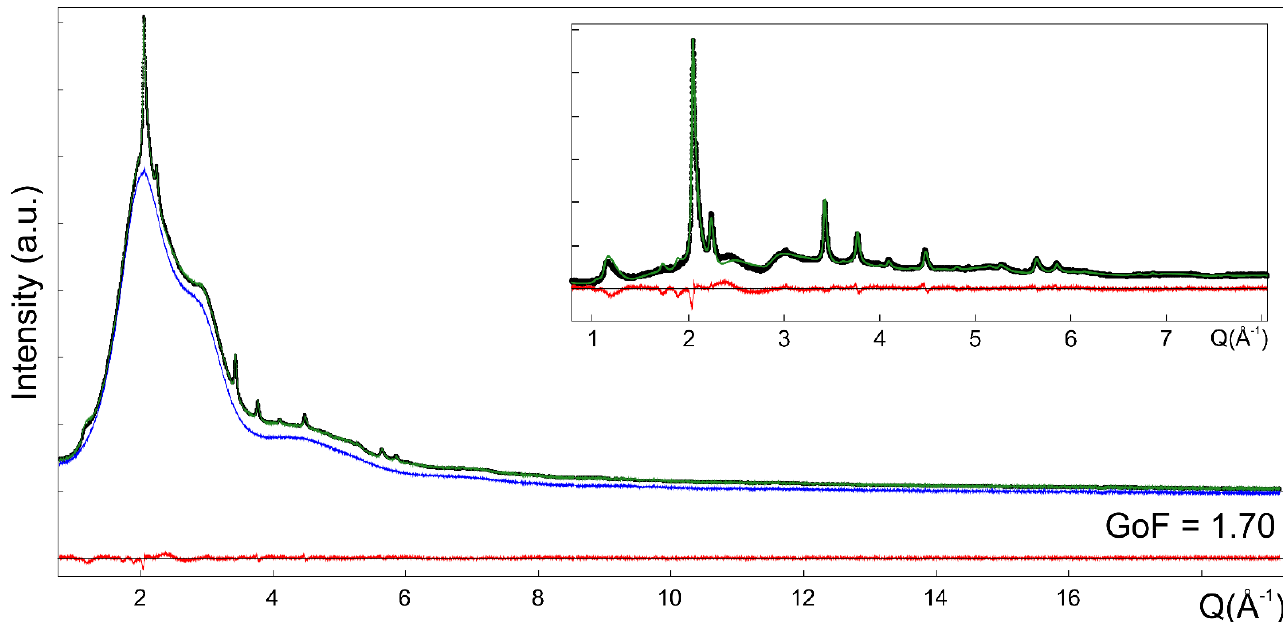
Figure 6. Synchrotron WAXTS data (black dots) of Me-S-H nanoparticles. The solid green line is the best fit obtained through the DSE using the Cu-doped single layer atomistic model; the red line is the residual between experimental and calculated patterns. The WAXTS pattern of the dispersing solution (blue trace) is added as a model component and scaled to the experimental data. The inset reports the WAXTS pattern and the DSE fit in a limited Q range by subtracting the scattering contribution of the solution.